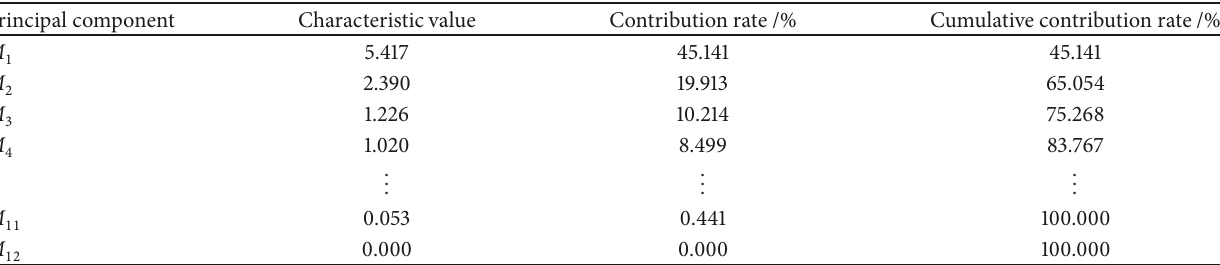
Table 3: Contribution rates of each principal component.